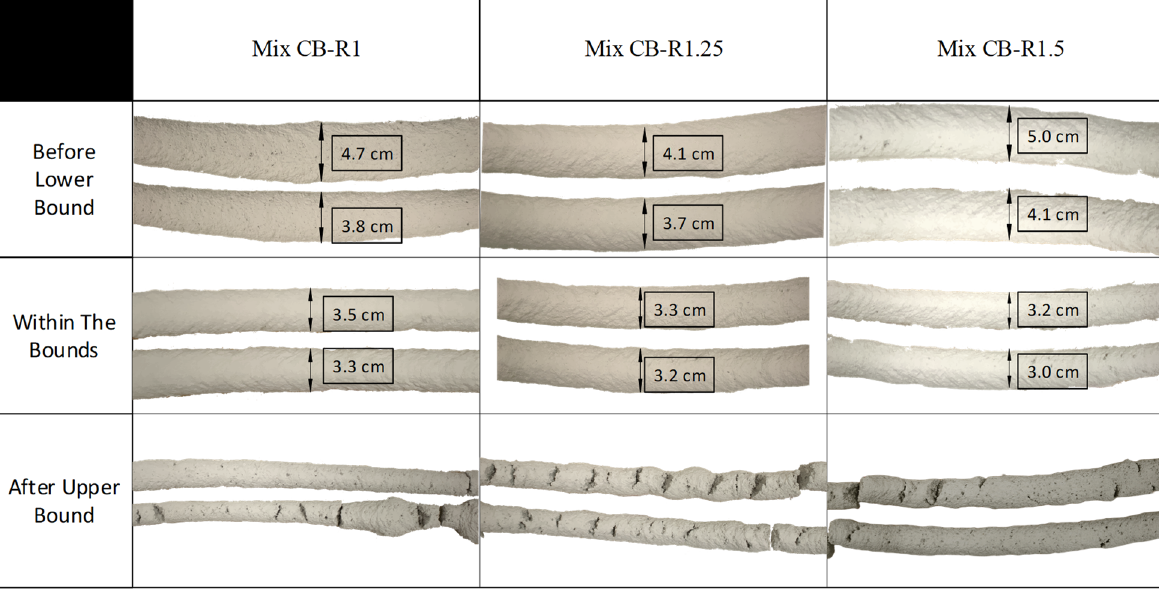
Figure 8. Printed single-layer filaments for mixes 1, 2, and 3 at various stages of